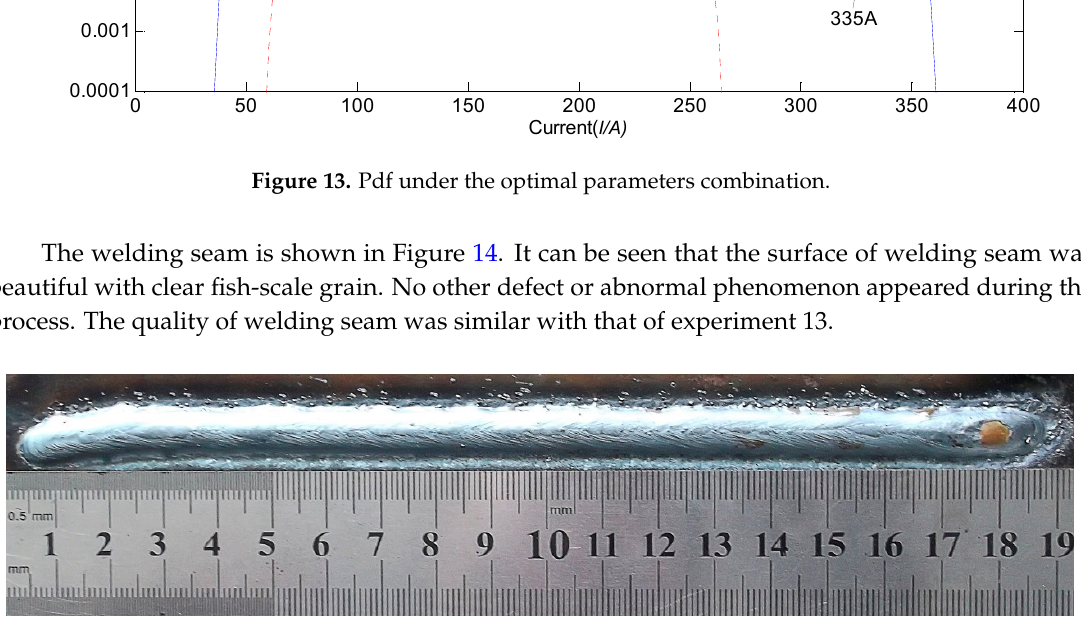
Figure 14. Weld surface under the optimized parameters.